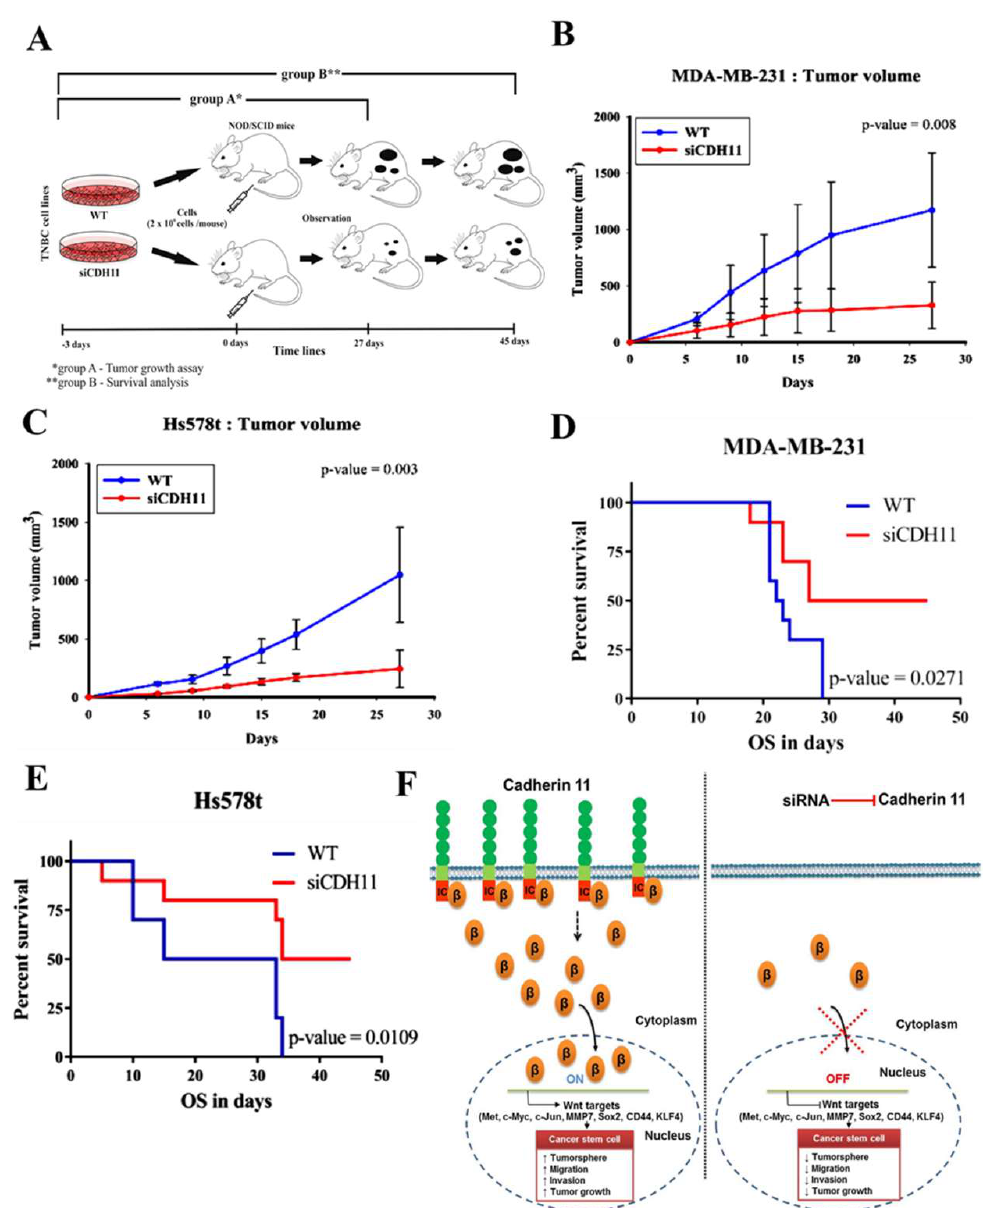
Figure 6. Silencing CDH11 significantly attenuates tumorigenicity of TNBC cells, in vivo. ( A ) Schema showing xenografts derived from NOD/SCID mice injected with 2 × 10 6 WT or siCDH11 MDA-MB-231 or Hs578t cells subcutaneously in the hind-flank and observed for 27 days (group A, n = 5/group) or 45 days (group B, n = 5/group). Graph showing difference in tumor volume over time for the WT or siCDH11 ( B ) MDA-MB-231 or ( C ) Hs578T tumor-bearing mice. Intergroup p -values were determined by